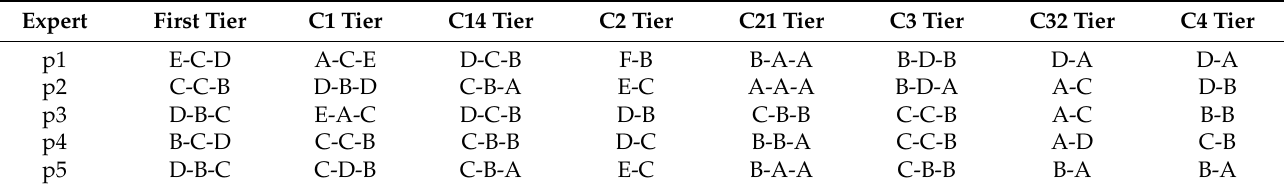
Table 5. Relative importance of